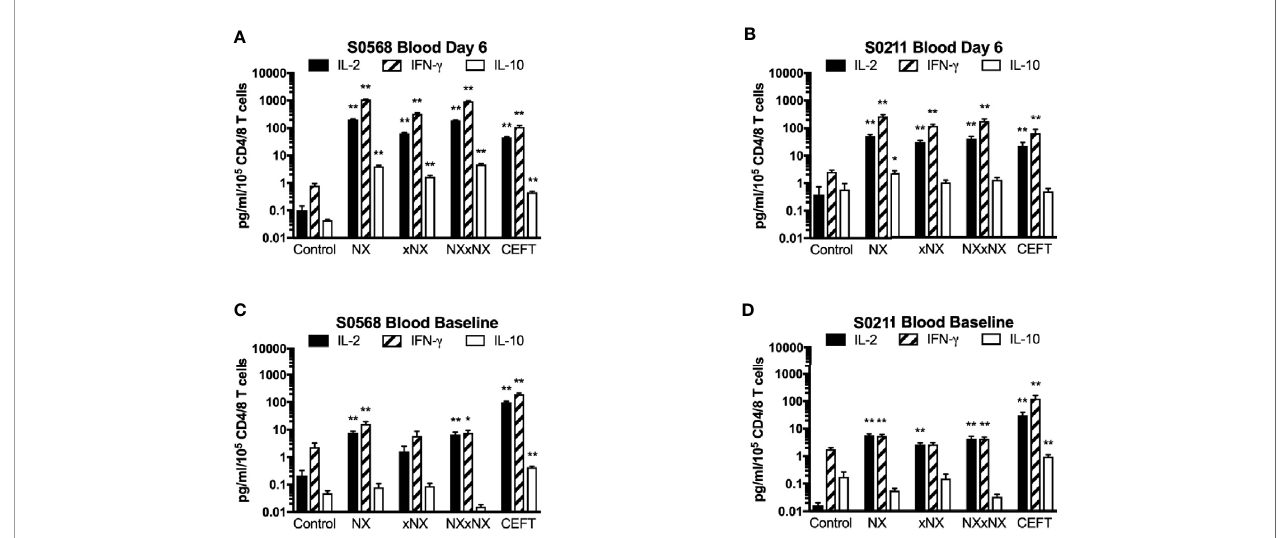
FIGURE 5 | Gluten peptide-stimulated 24-hour fresh whole blood IL-2, IFN- g , and IL-10 release normalised for the number of live CD3+CD4+ and CD3+CD8+ T cells in individual microwells were compared to the negative control in samples from two HLA-DQ2.5+ CD patients: after gluten challenge (A , B) or at baseline before gluten challenge (C , D) . Bars represent the mean and SEM of six replicate wells. Mann-Whitney U test was used to compare gluten peptide-stimulated cytokine release versus Control; statistical signi fi cance is indicated by *p < 0.05, or **p < 0.01.